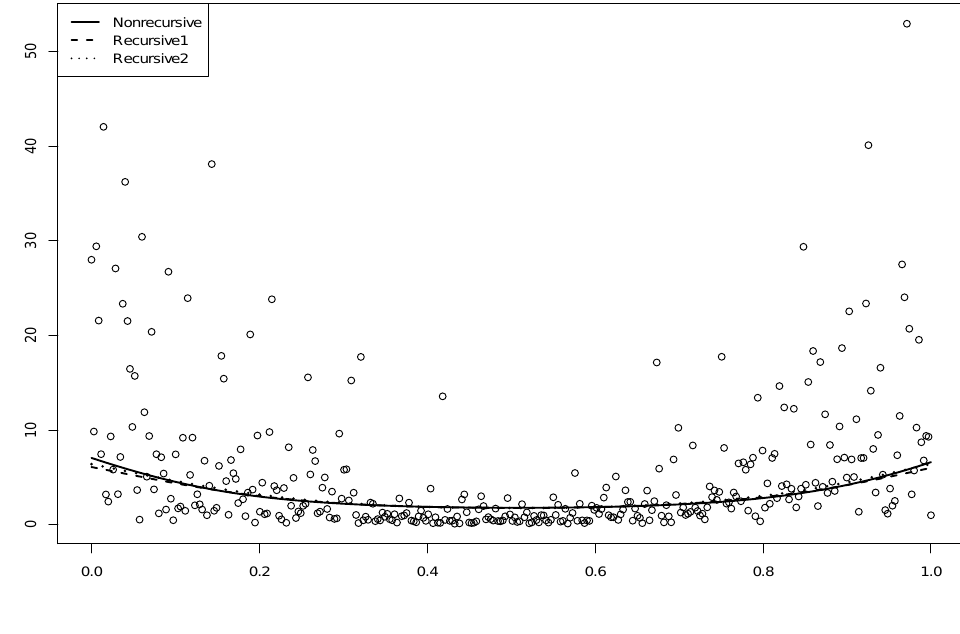
h k (cid:3)(cid:1) using model 2; µ ( X ) = k =1